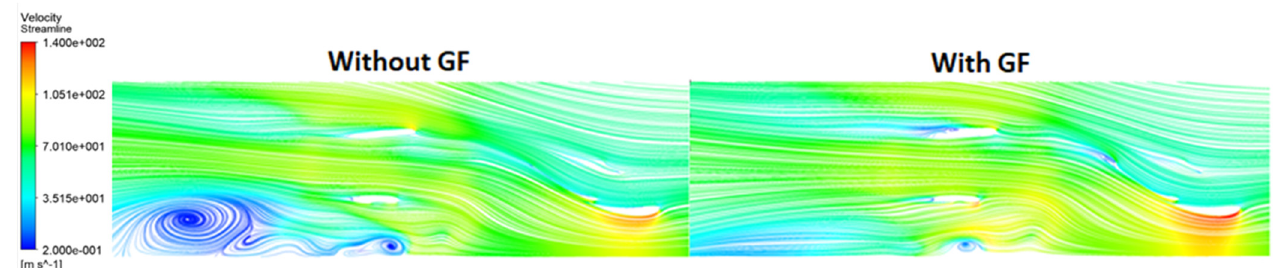
Figure 14. Comparison on the y 4 plane of the streamlines. Without ( left ) and with ( right ) GF. In Figure 15 the pressure contours on the y 3 plane are shown. They highlight that a large low-pressure area is generated on the nose of the connector with the GF and a reduction of the high-pressure zone below the suspension. These combined effects give more downforce with the GF installed.